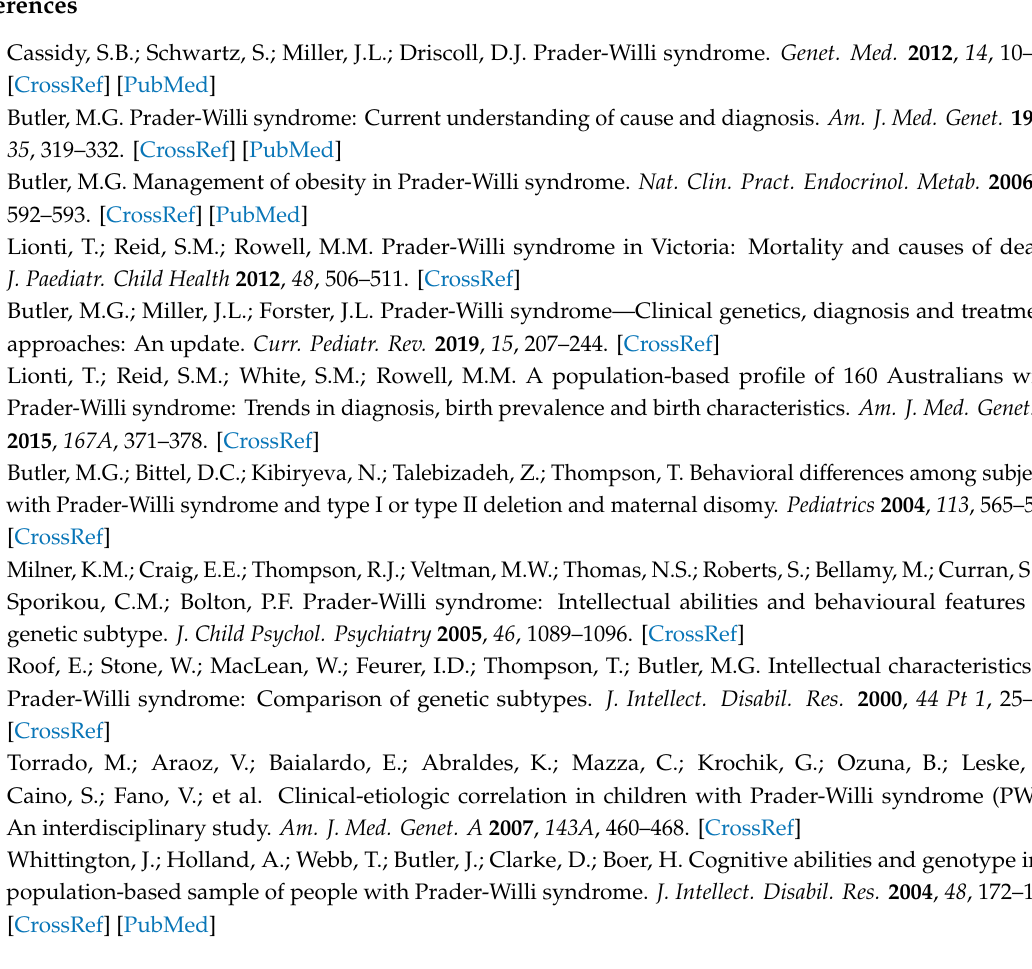
Figure S1: Comparison of the variograms and residual plots for a LMM (random slope only), a LMM (random slope and random intercept and a LMM with AR(1) correlation structure when fitting growth models (with 4 knots) for height for the female deletion subgroup, Table S1: Comparison of the Akaike information criterion and Bayesian information criterion for a LMM (random slope only), a LMM (random slope and random intercept and a LMM with AR(1) correlation structure when fitting growth models for height for the female deletion subgroup, Table S2: Mean di ff erence in rate of growth across age intervals between individuals with the deletion and non-deletion mechanism of PWS, estimated using linear mixed models with linear splines (adjusted for year of birth), with an interaction term between age and genetic